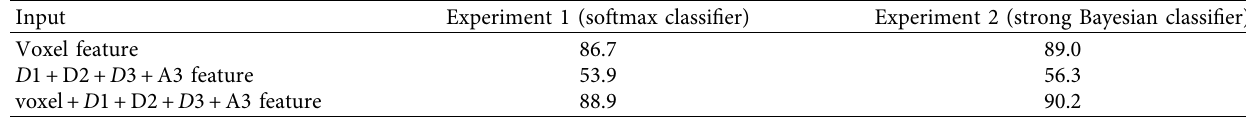
Table 1: Accuracy of 3D model classification under different inputs.